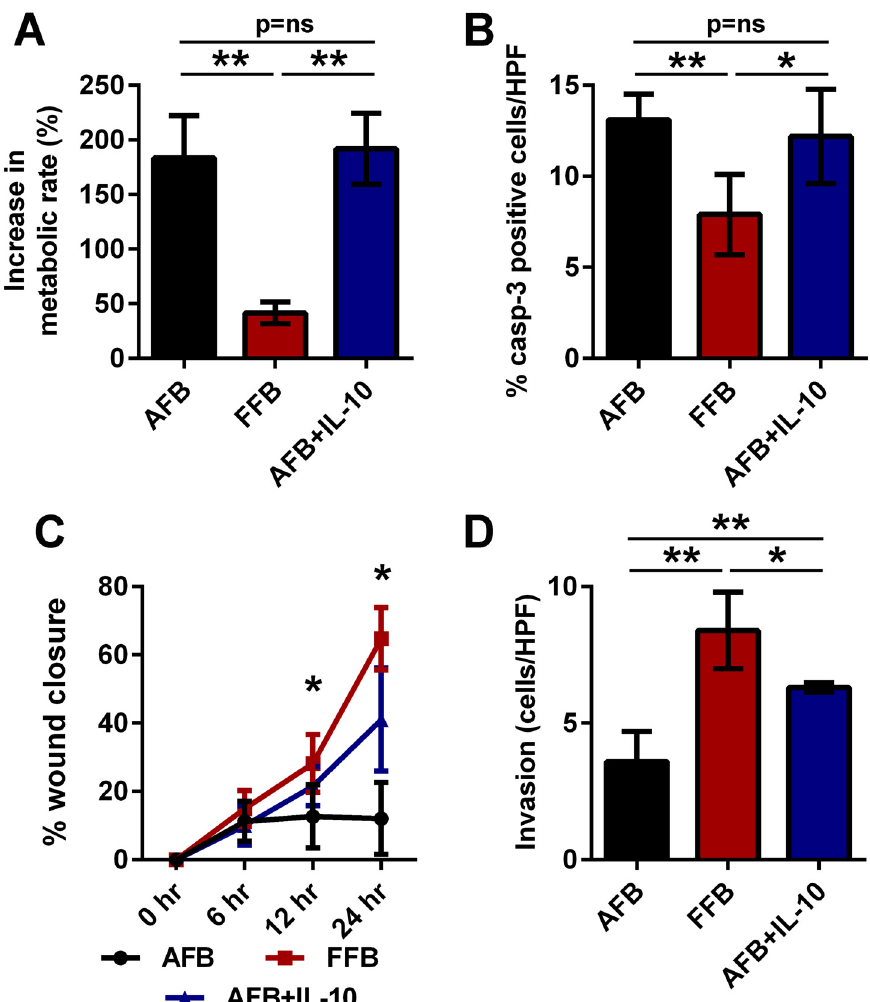
Fig 3. The role of IL-10 in recapitulating the fetal functional profile of AFB. A) Rate of metabolism, B) apoptosis, C) migration and D) invasion were compared between AFB, AFB+IL-10, and FFB to determine if IL-10 treatment can recapitulate the fetal functional profile in the FFB. IL-10 treatment recapitulated the migration and invasion aspects of the fetal-type fibroblast phenotype in AFB, but metabolism and apoptosis rates were not impacted by IL-10. Bar plots represent average ± SD. Asterisks denote statistically significant differences between the groups ( * p < 0.05, ** p < 0.01; Student ’ s t-test and ANOVA; n = 3 per group at similar passage number; each experiment was conducted in triplicates with cells from independent